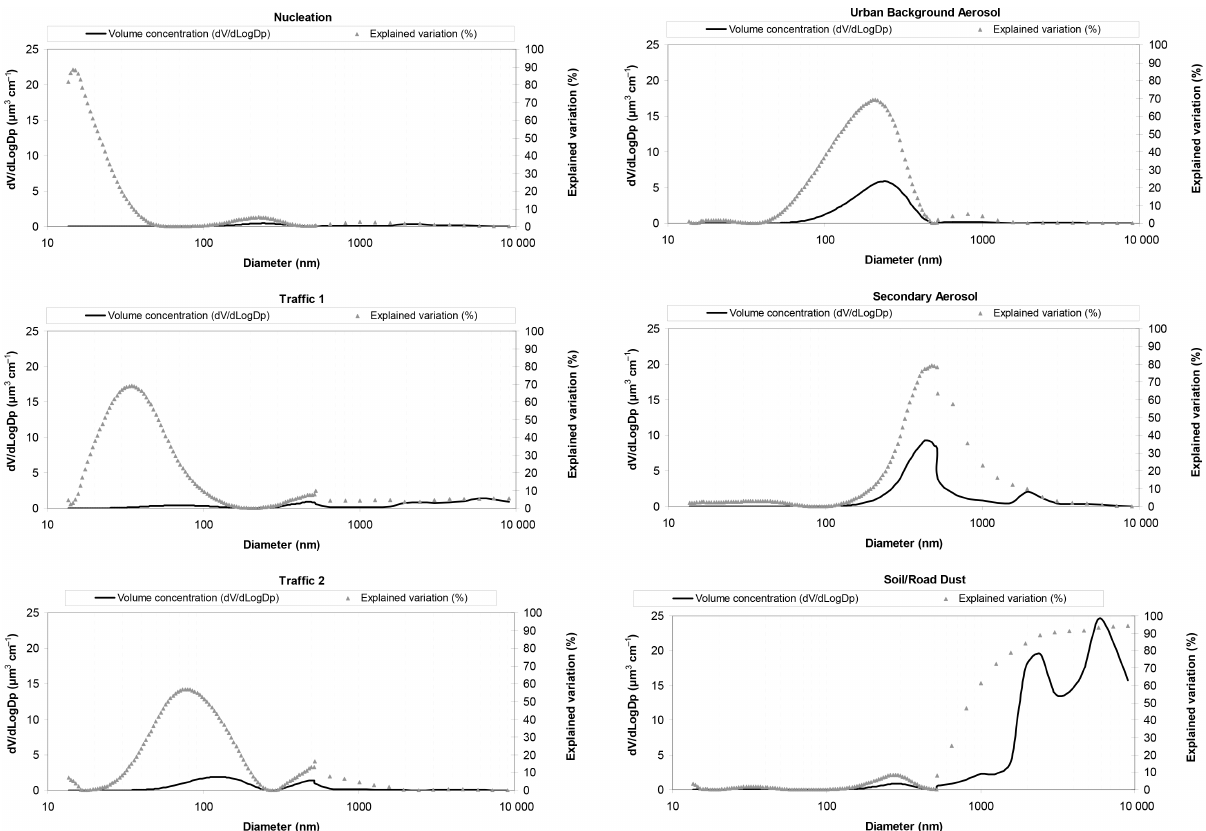
Figure 4. Volume size distributions along with the explained variation (%) of each factor profile resolved by the PMF model.